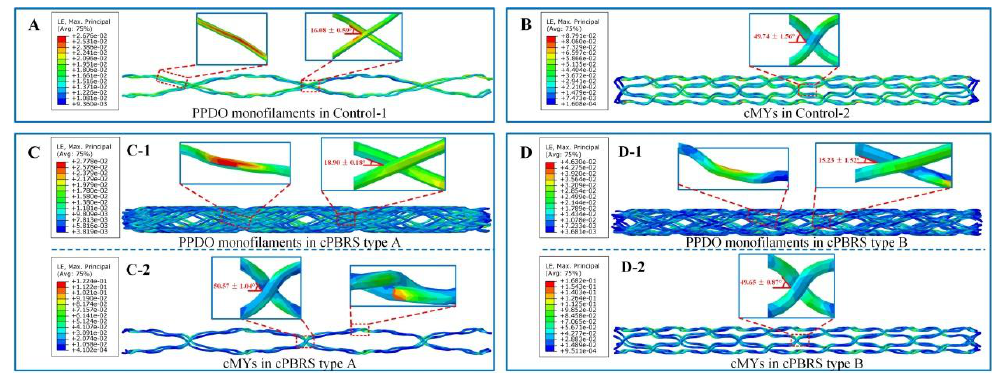
Figure 6. The Von Mise distributions of different prototypes after crimping to 3.8 mm in diameter. ( A ) The Control-1 prototype; ( B ) The Control-2 prototype; ( C ) The cPBRS type A prototype; ( D ) The cPBRS type B prototype.